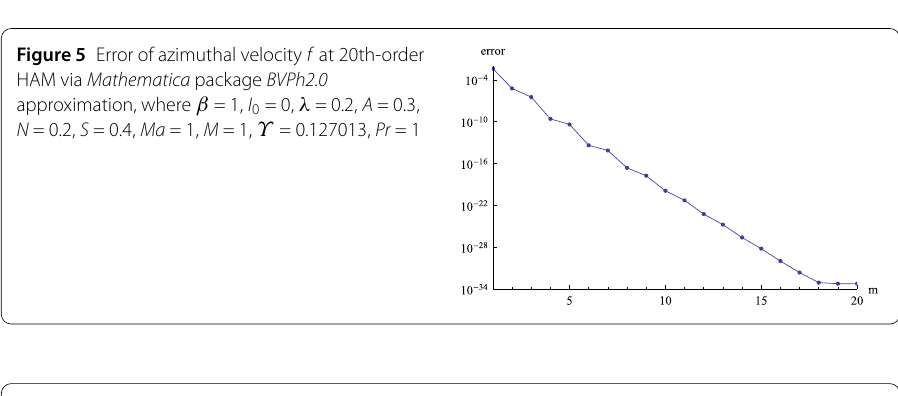
Figure 6 Error of θ ( η ) at 20th-order HAM via Mathematica package BVPh2.0 approximation, where β = 1, I 0 = 0, λ = 0.2, A = 0.3, N = 0.2, S = 0.4,